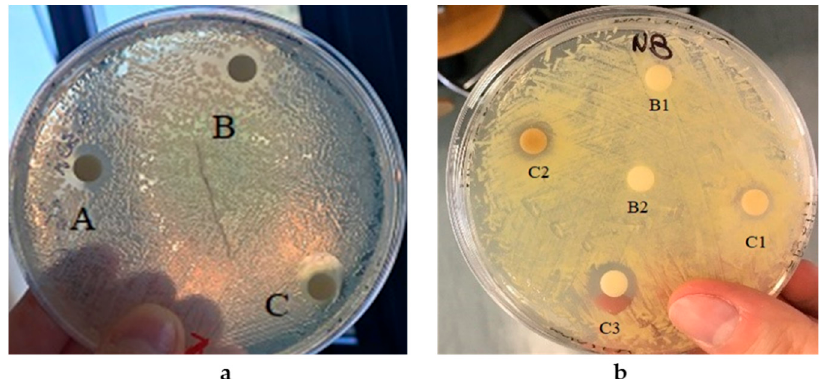
Figure 18. AgNPs’ effect against E. coli and K. rhizophila. Panel ( a ) E. coli in the presence of a AgNp solution containing 0.04 mg (spot B), 0.08 mg (spot A), or 0.16 mg (spot C). Panel ( b ) K. rhizophila in the presence of a AgNp solution containing 0.04 mg (spot C1), 0.08 mg (spot C2), or 0.16 mg (spot C3). Controls: 40 µL distilled water (spot B1) and CFS without AgNPs (spot B2). Table 3. Antimicrobial activity of SeNPs against K. rhizophila .